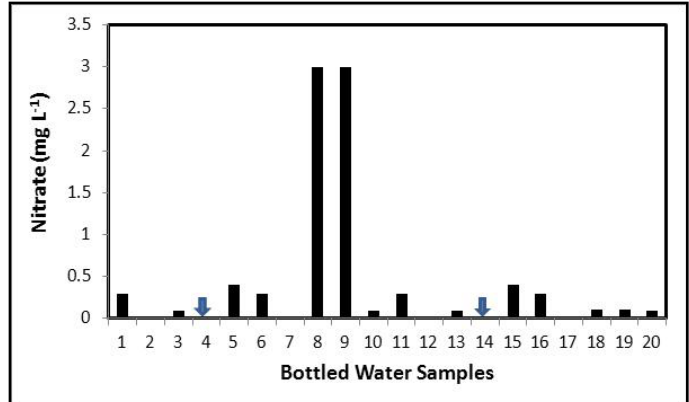
Figure 3. Anion concentrations ( a - d ) reported on the labels of bottled water samples. Only bottled water samples with bars and (representing zero value) reported values for the